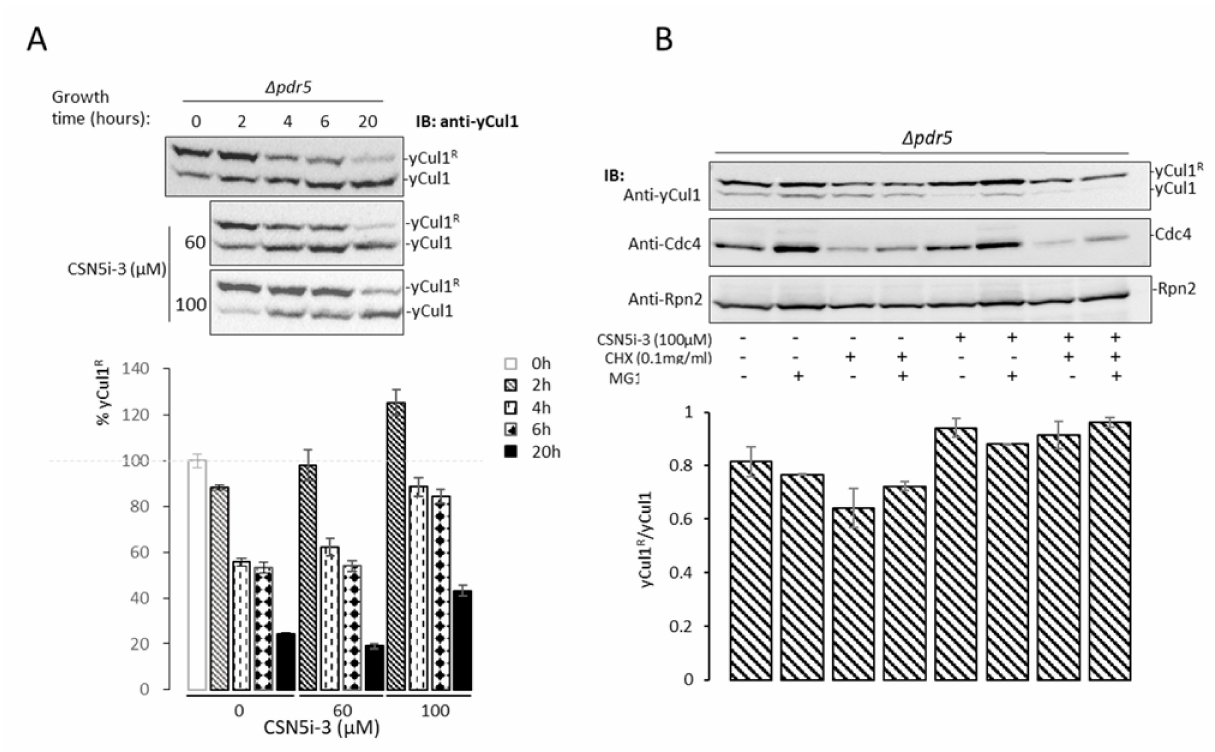
Figure 5. The human Csn5 inhibitor CSN5i-3 is compatible to S. cerevisiae . ( A ) Logarithmic ∆ pdr5 cells were treated with CSN5i-3 (0, 60, and 100 µ M) for indicated times (0–20 h). The neddylation status of yCul1 was calculated through IMAGEJ from three independent experiments, shown as % of neddylation from the starting 0-h time-point (bottom). ( B ) ∆ pdr5 cells at the early log phase were treated with CSN5i-3 (100 µ M), cycloheximide (CHX) (0.1 mg/mL), and MG132 (50 µ M) to assess the inhibition effect of CSN5i-3 on deneddylation. Representative immunoblots of yCul1 show the effect of the different treatments on yCul1/yCul1 R ratio with the short-lived protein Cdc4 as control for CHX and MG132 inhibition treatments. Rpn2 expression is presented as a loading